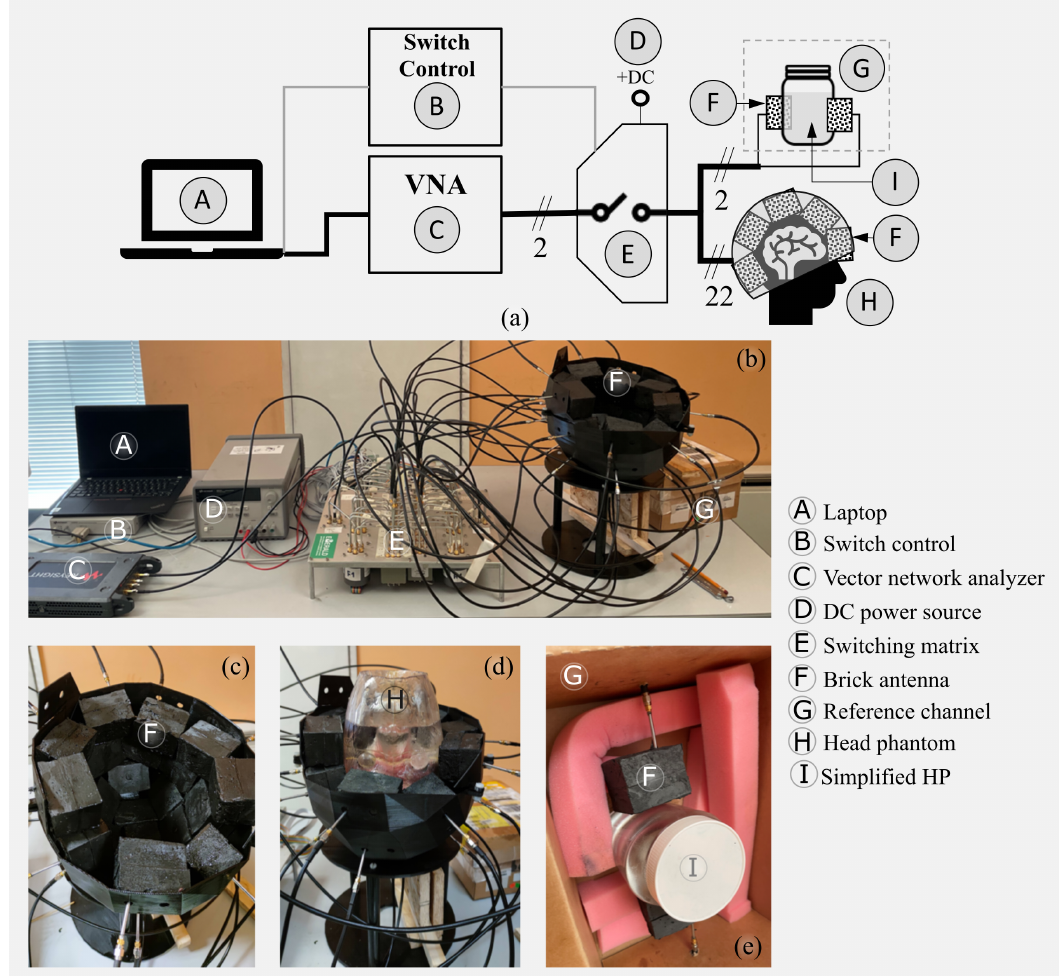
Figure 1. Microwave brain imaging system prototype: ( a ) block diagram, ( b ) overview, ( c ) 22-element antenna array helmet, ( d ) anthropomorphic adult head phantom within the helmet, and ( e ) reference channel